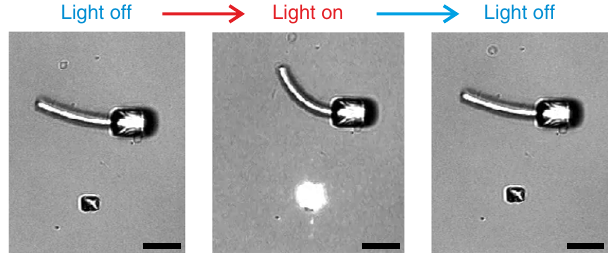
Fig. 6 Indirect stimulation by a spatially separated structure. The bi- material beam in the top part of the images is fabricated by the pNIPAM resist as described previously, while the small blocks on the bottom are made out of PETA with the photoinitiator Irgacure 819. The laser is focused on the PETA block and by photo-thermal conversion of the two-photon absorbed light, heat is generated. This heat is distributed in the water and leads to an actuation of the bi-material beam. The PETA block itself does not experience any measureable structural change or response to the stimulation. Scale bars are 20 µ